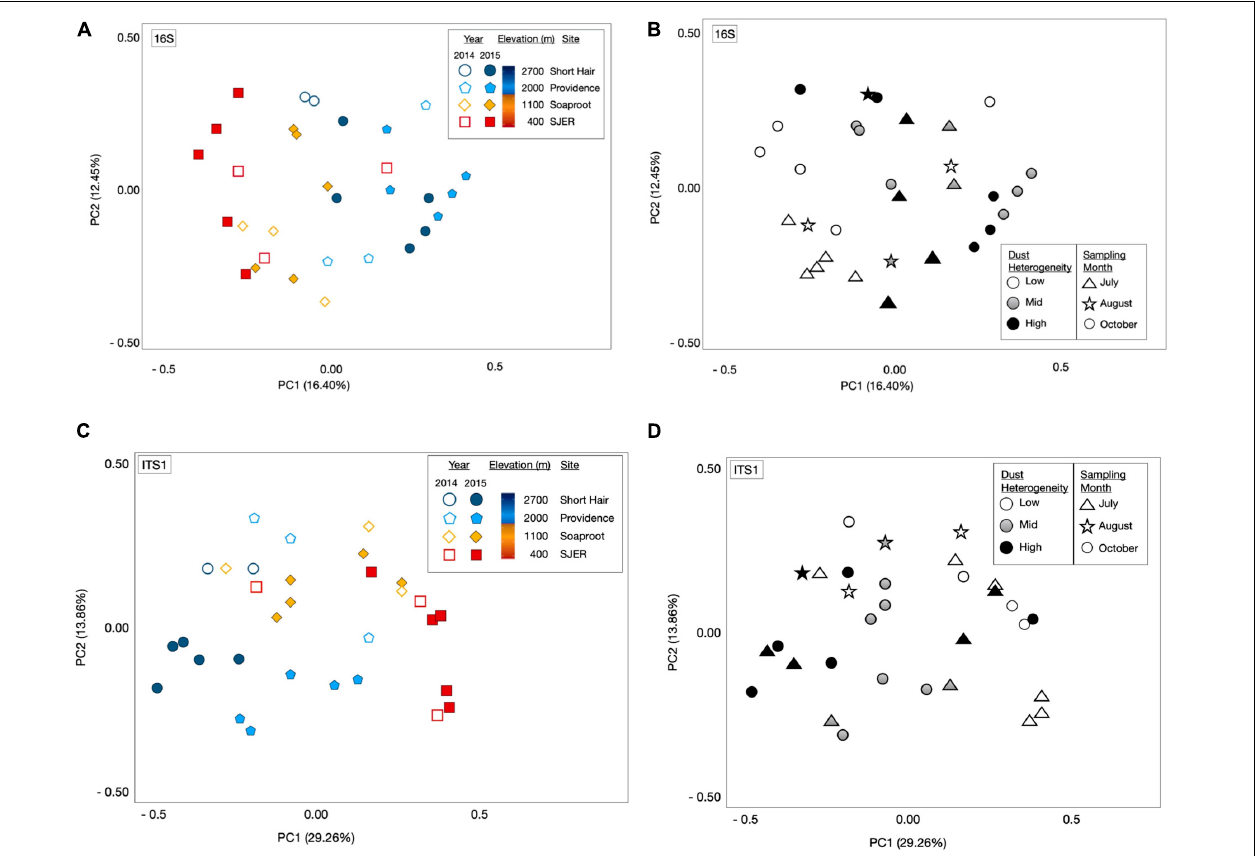
FIGURE 3 | Microbial community composition shifts by elevation and sampling date. Principal coordinate analyses (PCoA) of 16S rRNA gene bacterial OTU microbial community composition revealed from targeted amplicon sequencing of marker genes (A) and the amplicons of the fungal ITS1 (C) region illustrated structural shifts by elevation and sampling year, as well as dust heterogeneity and sampling month (B,D) . Microbial communities represented by either open or filled shapes, corresponding to dust sampling year; two California drought years (2014 and 2015) and one Asian drought year (2015). 2014 dust microbiomes (A) , shown as open shapes with outlines colored by site); 2015 color filled shapes (A) with black outlines; colors corresponded to sites (as per legend, and on Figure 1 : Map). Bacterial [16S rRNA marker genes; (A) ] and fungal communities [ITS1 region; (C) ] varied across elevation and sampling year. Dust bacterial (B) and fungal (D) communities in greyscale, ranked by dust heterogeneity (Low = white; Mid = gray; High = black), which was related to the proportion of Asian dust in samples deposited in California’s Sierra Nevada. Symbols in (B) (bacterial communities) and (D) (fungal communities) represented sampling months, with triangles for July, stars for August, and circles for dust samples collected in